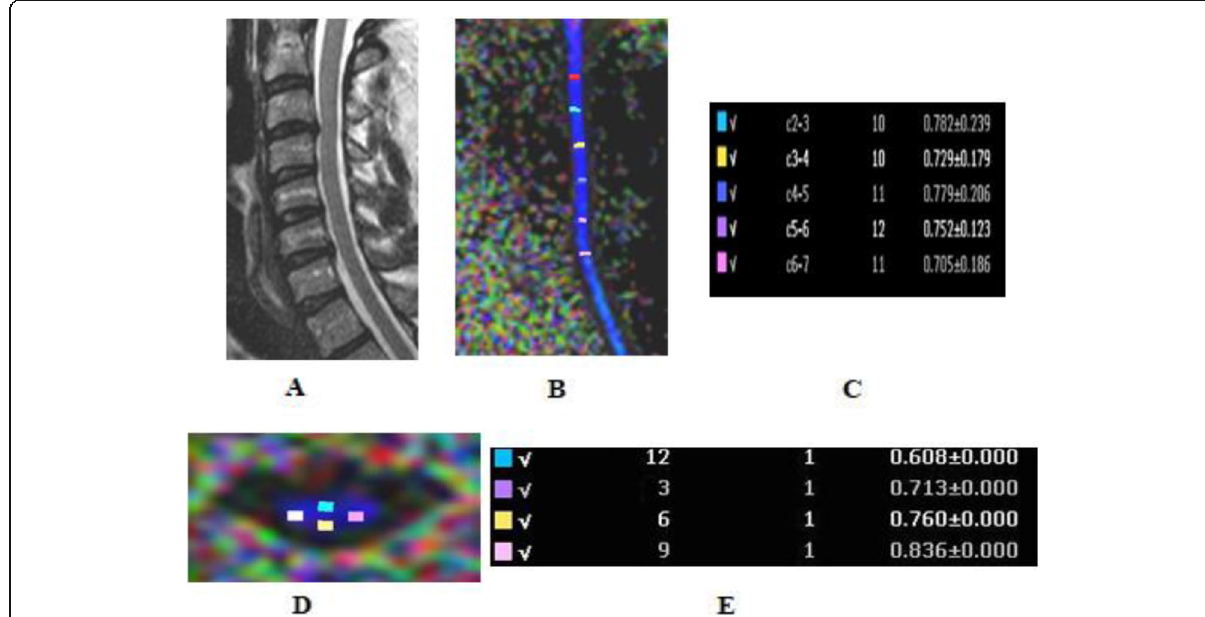
Fig. 6 Thirty-six-year-old male patient, presented with neck pain and bilateral brachialgia. a Sagittal T2 WI of the cervical spine showing C3-4 and C6-7 posterior disc lesions, just touching the ventral aspect of the cord at C3-4 level, with no signal intensity alteration of the cord. b Color-coded FA map, showing no significant changes of the blue color of the cord, with multiple ROIs opposite to different disc levels. c FA values of the whole cord circumference opposite to all the examined cervical discs, showing no gross abnormality. d , e FA values of the spinal cord at 3, 6, 9, and 12 o ’ clock positions opposite to C3-4 disc, showing mild reduction in FA value opposite to 12 o ’ clock, denoting early myelopathy, although the normal FA value of the whole cord